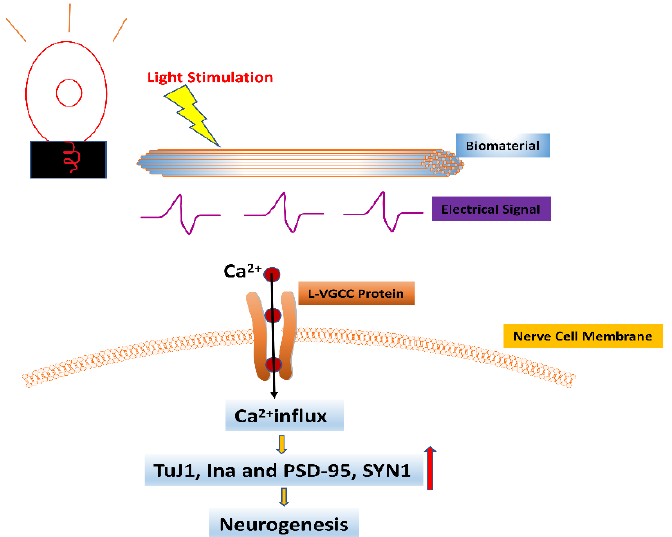
Figure 3. The effect of light stimulation combined with biomaterials on neurons. The electrical signal generated by the action of light stimulation on biomaterials promotes the opening of L-VGCC protein in nerve cell membranes, leading to Ca 2+ inward flow, which in turn activates a series of intracellular cascades leading to the upregulation of expression levels of neural-associated genes β -Tubulin (TuJ1), neurofilament 66 (Ina), and neurogenic protein markers including postsynaptic density 95 (PSD-95) and synaptophysin 1 (SYN1), ultimately promoting neurogenesis. (Orange arrow represents promotion, red arrow represents increase)